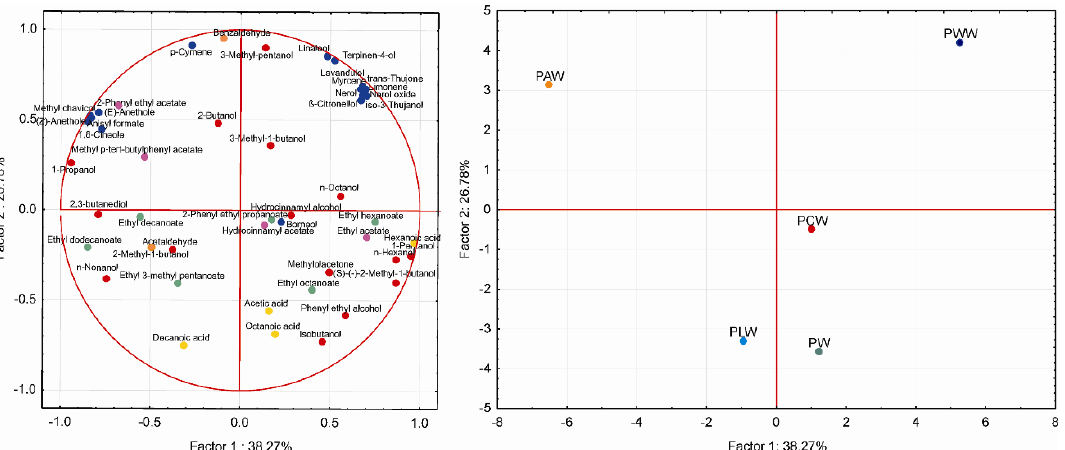
Figure 1. Principal Component analysis (PCA) based on the volatile aroma compounds in the ‘Prokupac’ wine samples (control and aromatised with aromatic herbs).